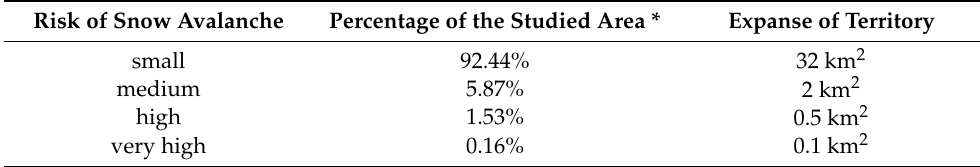
Figure 3. The avalanche release potential within the studied area compared with records in the existing avalanche cadastre. Table 3. Proportional outcome of territories endangered with avalanche